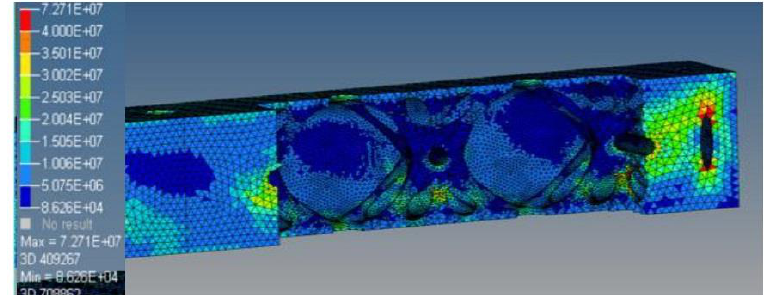
Figure 14. FEA results of Edge Insert.